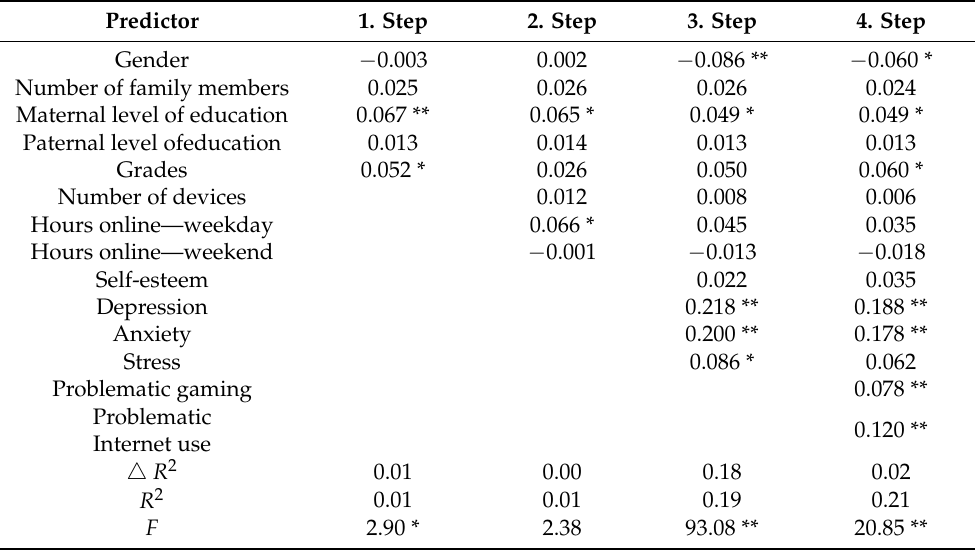
Table 9. HRA with experiencing as criteria.